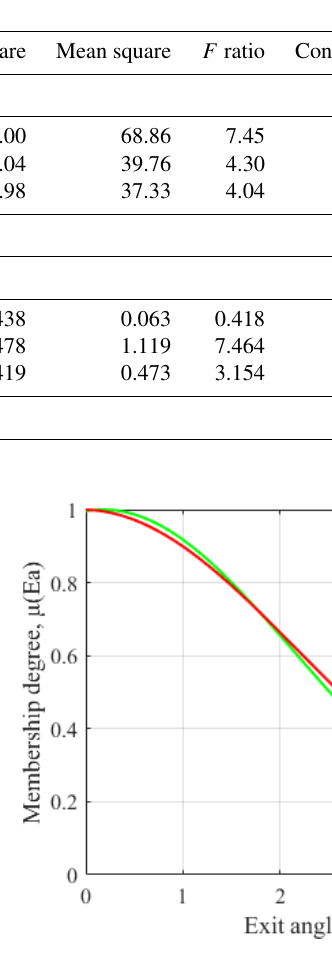
Table 8. Analysis of variance results for tool life and height of cutting burrs.